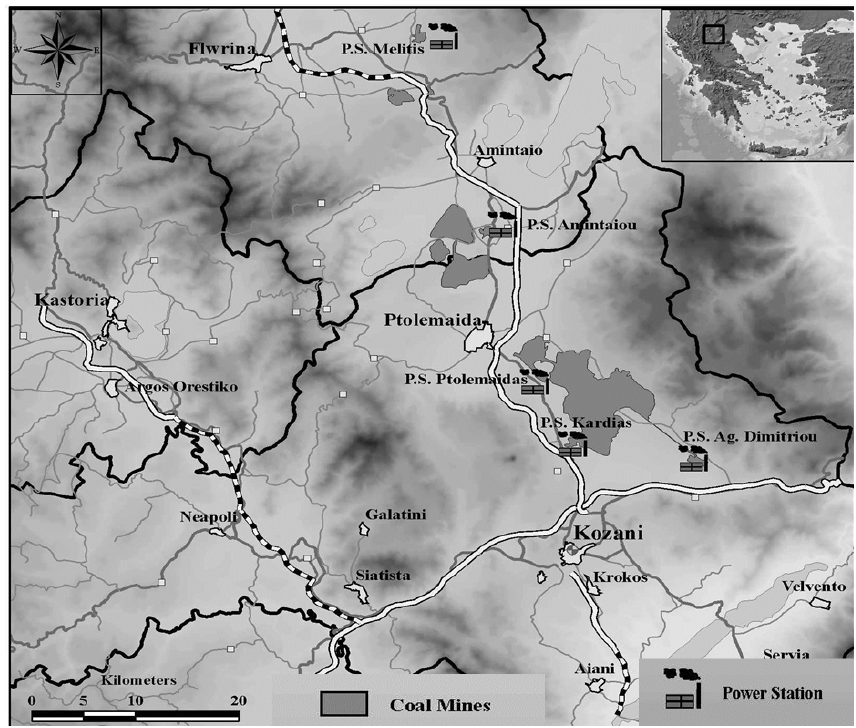
Figure 1. Map of the area of Eordea basin. The sampling site located at Kozani